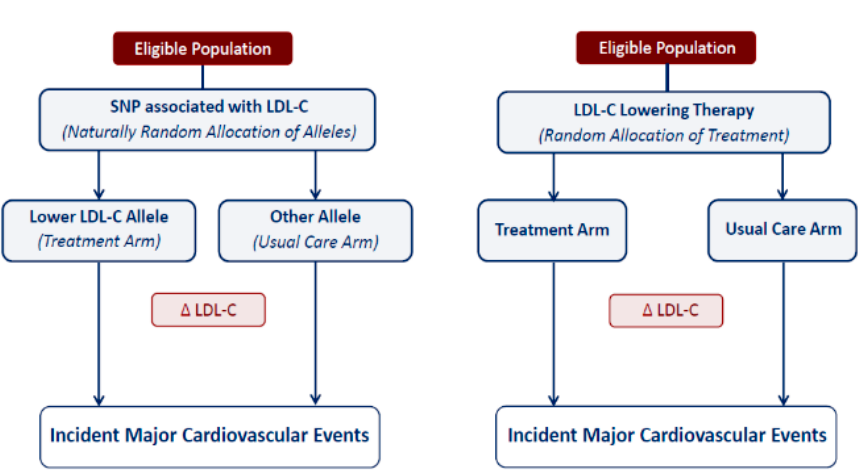
Figure 2. A Mendelian randomization study is analogous to a randomized trial.